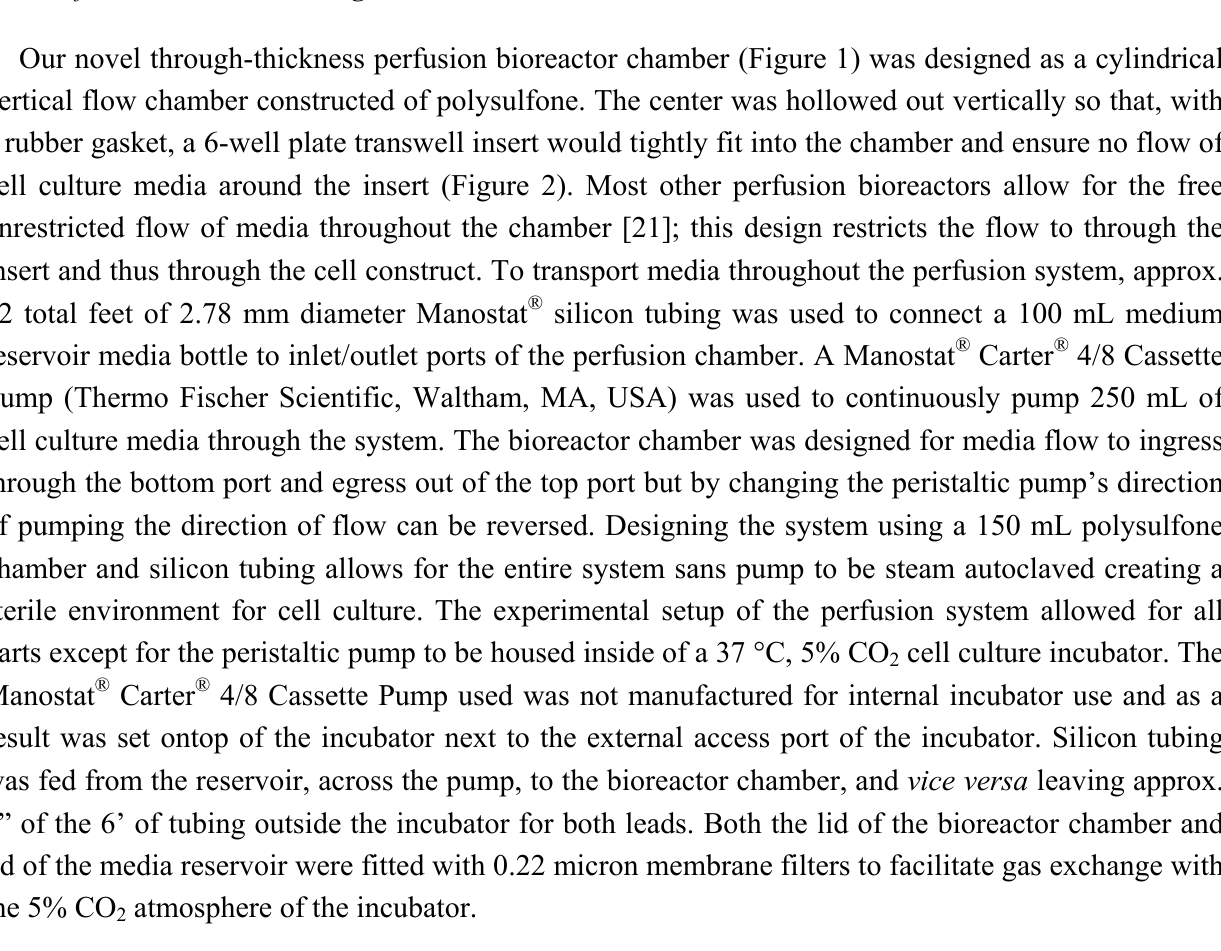
Figure 1. Perfusion Bioreactor ( A ) Side view of the perfusion chamber; ( B ) Top down view of the perfusion chamber; ( C ) Representation of the bioreactor setup with peristaltic pump and media reservoir